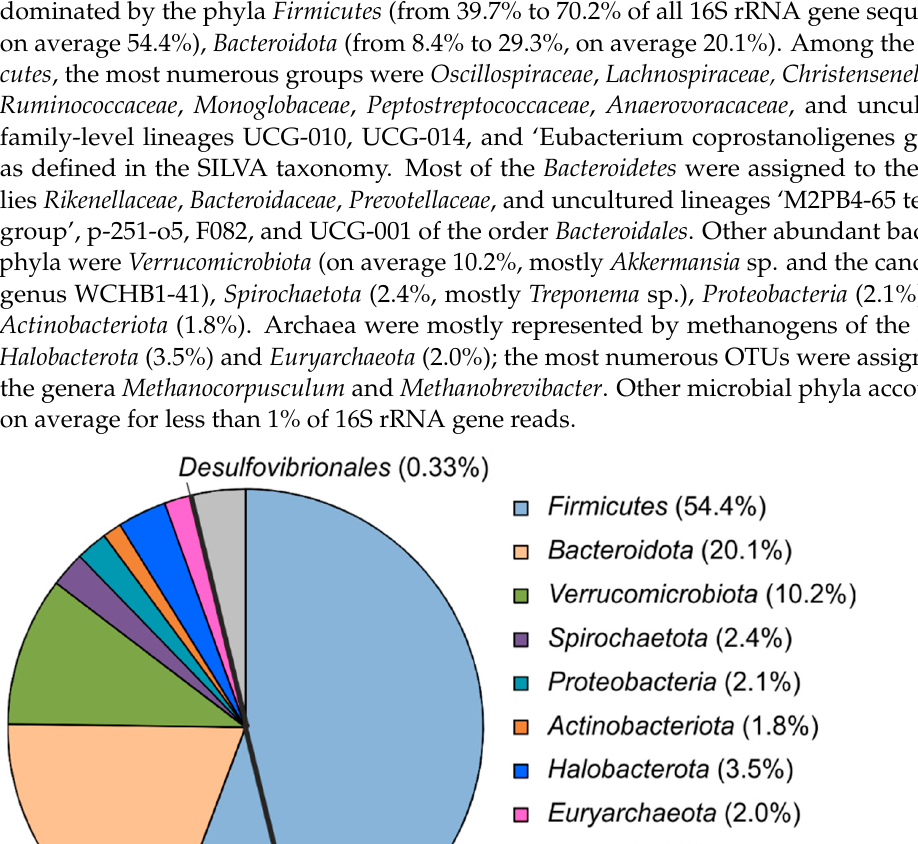
Figure 4. The sulfate reduction rate (SRR) measured in samples KV104, KV147, and KV 149. The vertical bars show the standard deviation.